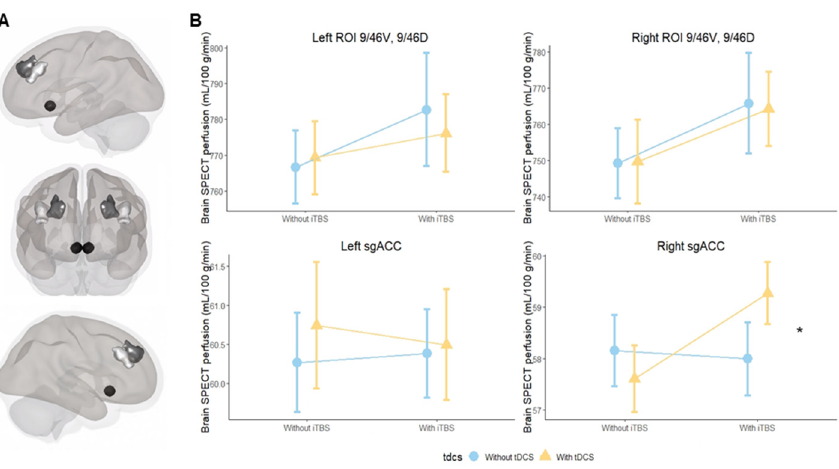
Figure 2. ( A ). Main regions of interest; ( B ). Cerebral blood flow changes in NIBS protocols over the targeted DLPFC and the sgACC. Note: Region BA 9/46D is represented by dark gray, region BA 9/46V is represented by light gray, and the sgACC is represented by black. Abbreviations: iTBS: intermittent theta-burst stimulation; min: minutes; mL: milliliter; g: gram; SPECT: Single-Photon Emission Computed Tomography; sgACC: subgenual anterior cingulate cortex; tDCS: transcranial direct current stimulation; *: significant result. Table 1. Main results. Abbreviations: CI: confidence interval; iTBS: intermittent theta-burst stimulation; sgACC: subgenual anterior cingulate cortex; tDCS: transcranial direct current stimulation. Note: all active interventions were compared to sham.